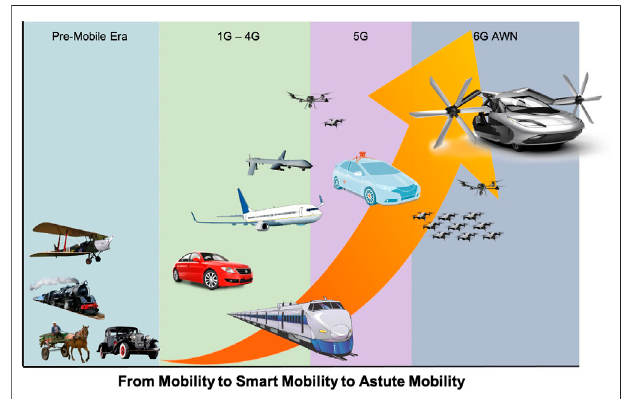
FIGURE 3 | Evolution of mobility in conjunction with the advancement in mobile network